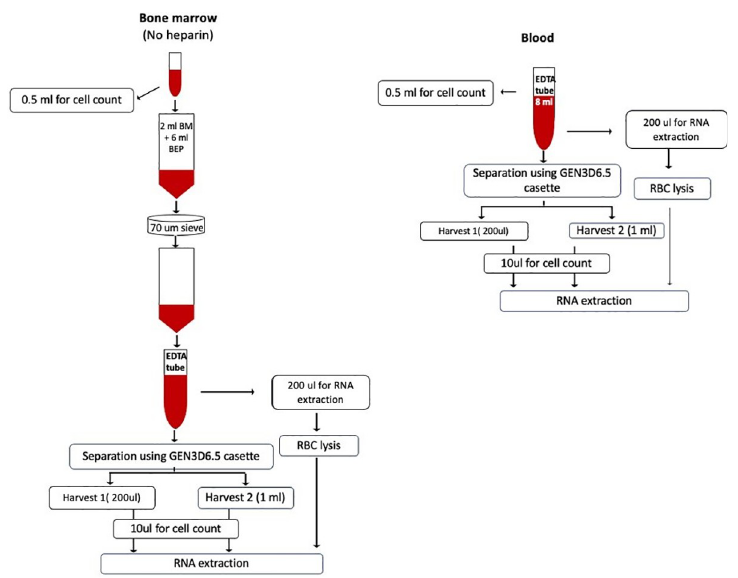
Fig 1. CTC/DTC enrichment workflow using Parsortix